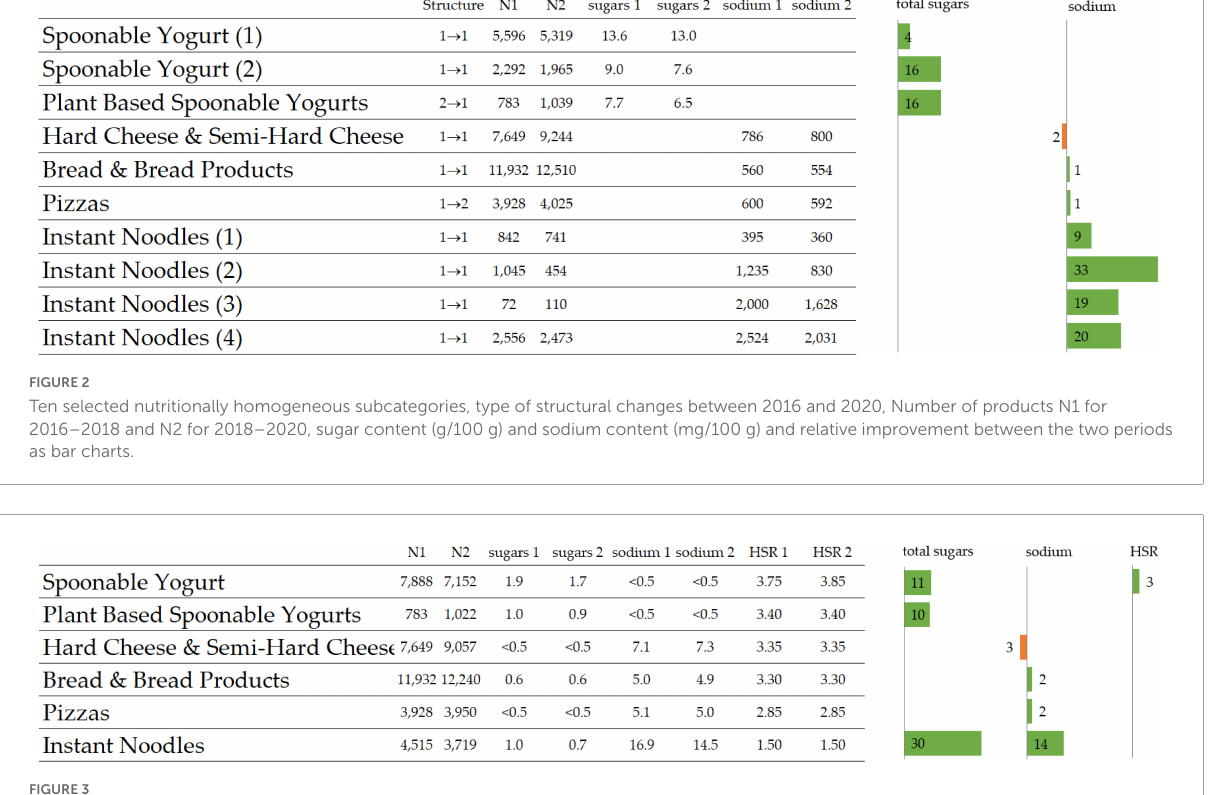
distribution of protein content of Pizzas category which was unimodal in 2016–2018 and ranged from 0 g/100 g to 23.1 g/100 g, became bimodal in 2018–2020 with one mode at 9.8 g/100 g and one at 12.4 g/100 g, and a split between the